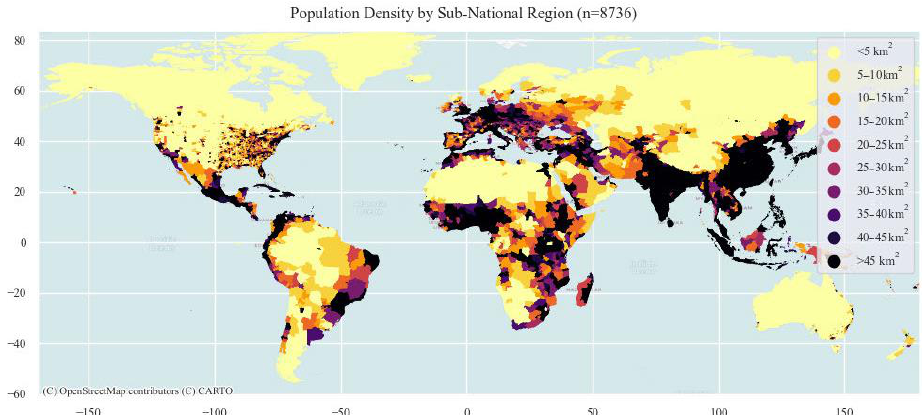
Figure 3. Global population density by provincial administrative division. The above global popu- lation density data are derived from the WorldPop database. https://hub.worldpop.org/geodata/ listing?id=76 (accessed on 20 December 2022) [25].